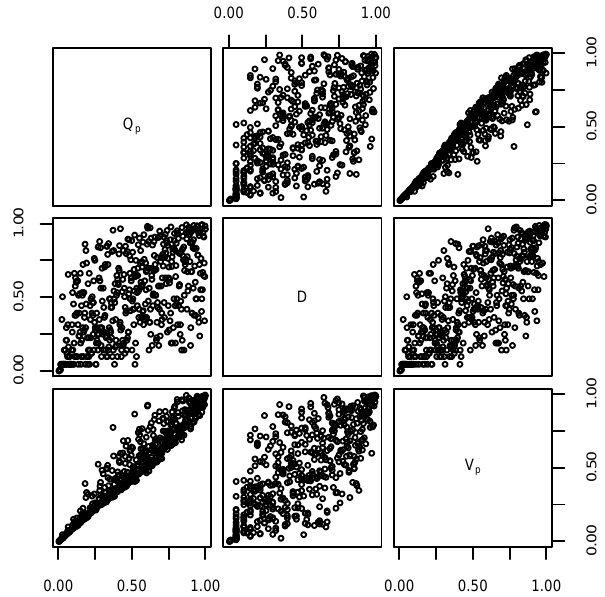
Fig. 4. Normalized rank scatter plots for all pairs of variables. Kendall’s tau is 0.85 for ( Q p ,V p ), 0.42 for ( Q p ,D ) and 0.54 for ( V p ,D